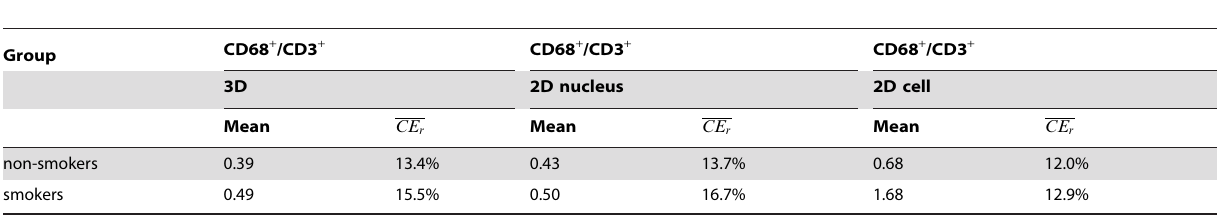
Table 3. CD68 + /CD3 + Cell Ratios by Group and Counting